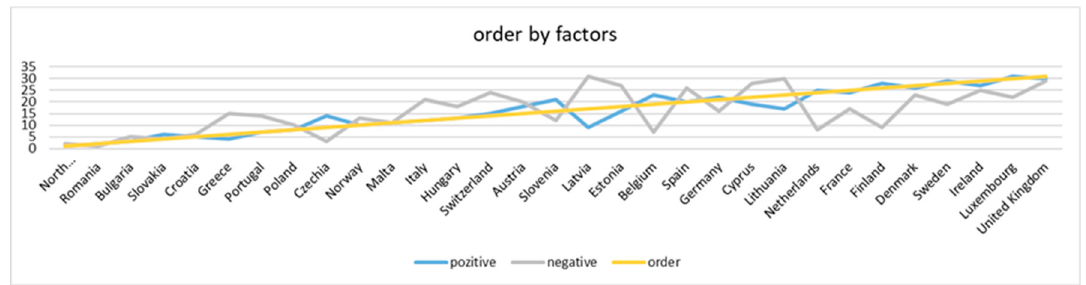
Figure 2. Factors—rank.